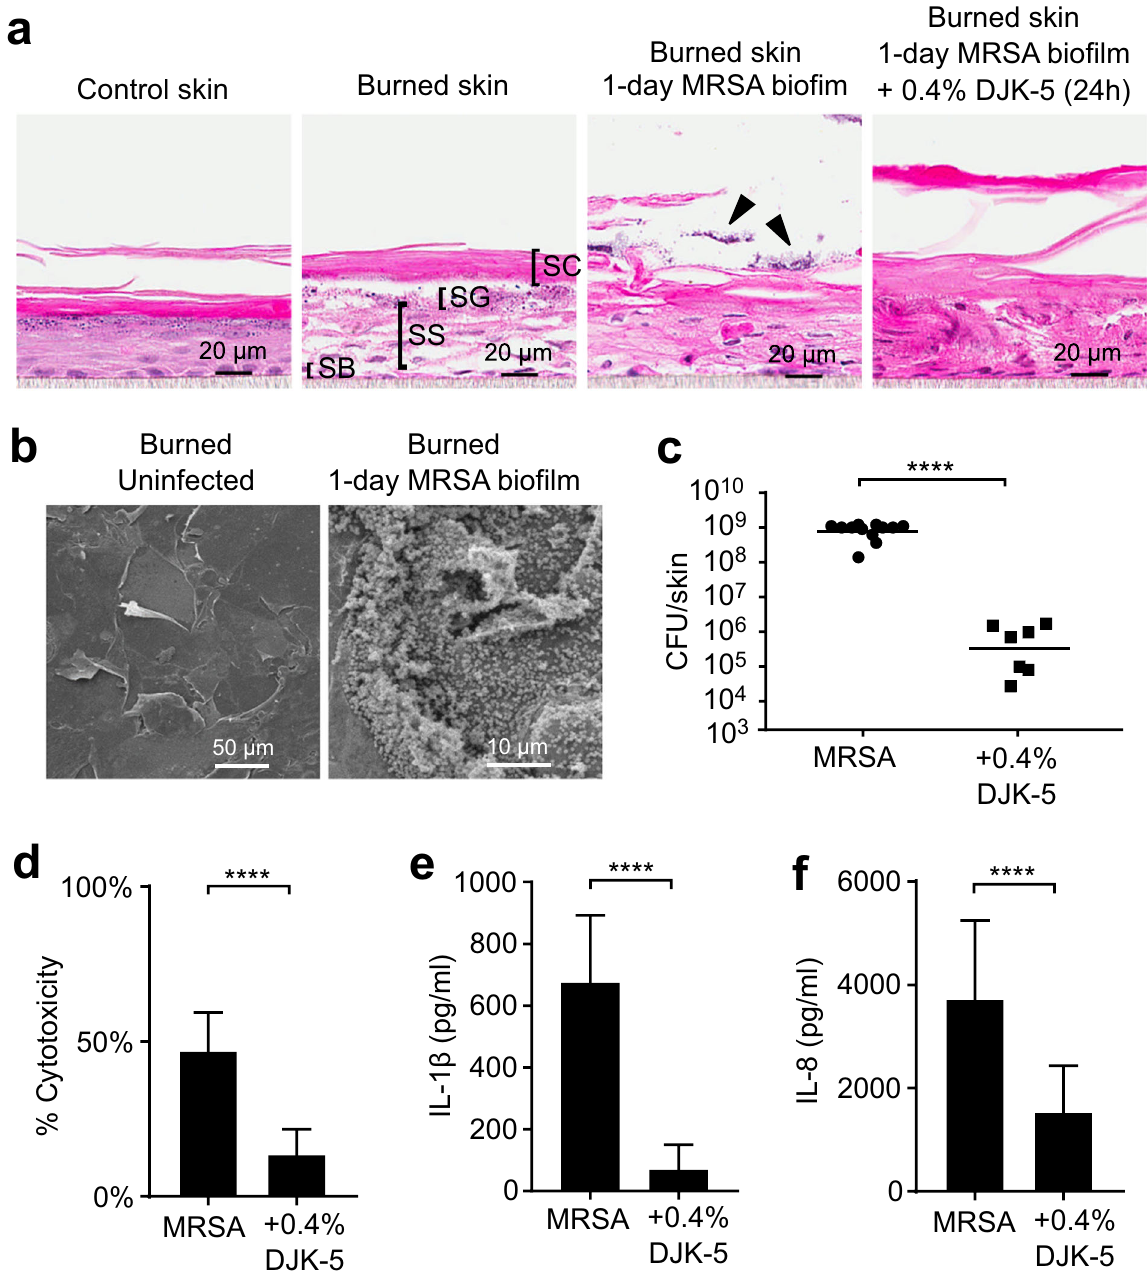
Fig. 5 DJK-5 reduced MRSA bio fi lm, cytotoxicity, and pro-in fl ammatory cytokine production in a thermal burn skin model. Skin samples were subjected to thermal wounding for 4 s at 100 °C. One million MRSA (USA300-LAC) was then spotted on top of the burned skin and cultured for 24 h. Cross-sections of epidermal layers corresponding to the stratum corneum (SC), stratum granulosum (SG), stratum spinosum (SS) and stratum basale (SB) were visualized by H&E (arrows indicate MRSA bio fi lm) ( a ). ( b ) The burned skin and bio fi lm on top were visualized by SEM. ( c ) DJK-5 peptide in PBS at a dose of 0.4% (120 μ g) or — as control — PBS was subsequently applied topically for 24 h. Samples were collected for bacterial counts (bars indicate geometric mean). ( d ) Culture supernatants below the fi lter inserts were used for measuring cytotoxicity by the lactate dehydrogenase assay. The amount of IL-1 β ( e ) and IL-8 ( f ) in the media below the fi lter inserts was quanti fi ed by ELISA. Error bars indicate mean with SD in ( d – f ). Statistical signi fi cance was calculated using the Mann-Whitney test ( c ) or the student ’ s unpaired t -test ( d – f ) from 7 to 12 biological replicates (**** P ≤